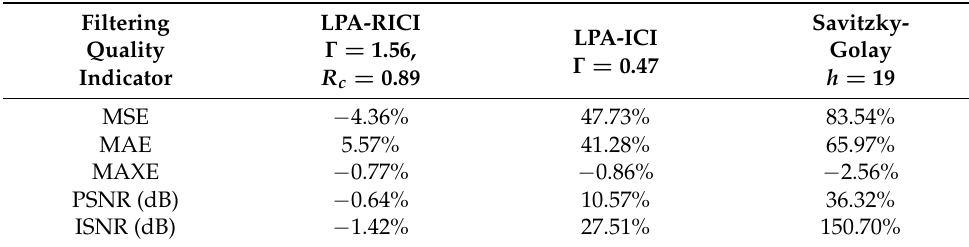
Table 6. Blocks signal (SNR = 10 dB)—Filtering quality improvement of the RBF-RICI-based filtering over other tested algorithms.